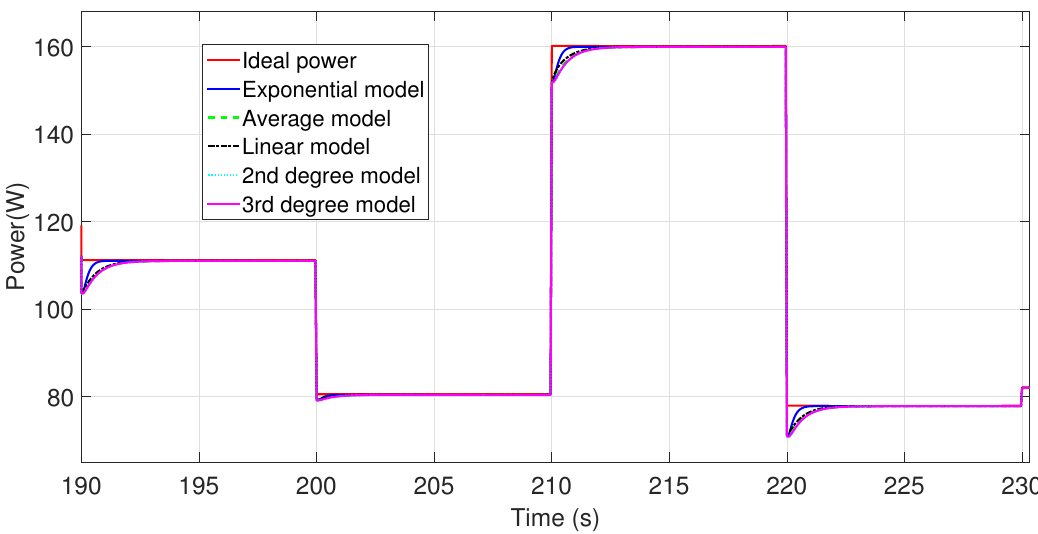
Figure 12. Ideal and instantaneous power for the proposed models from 190 to 230